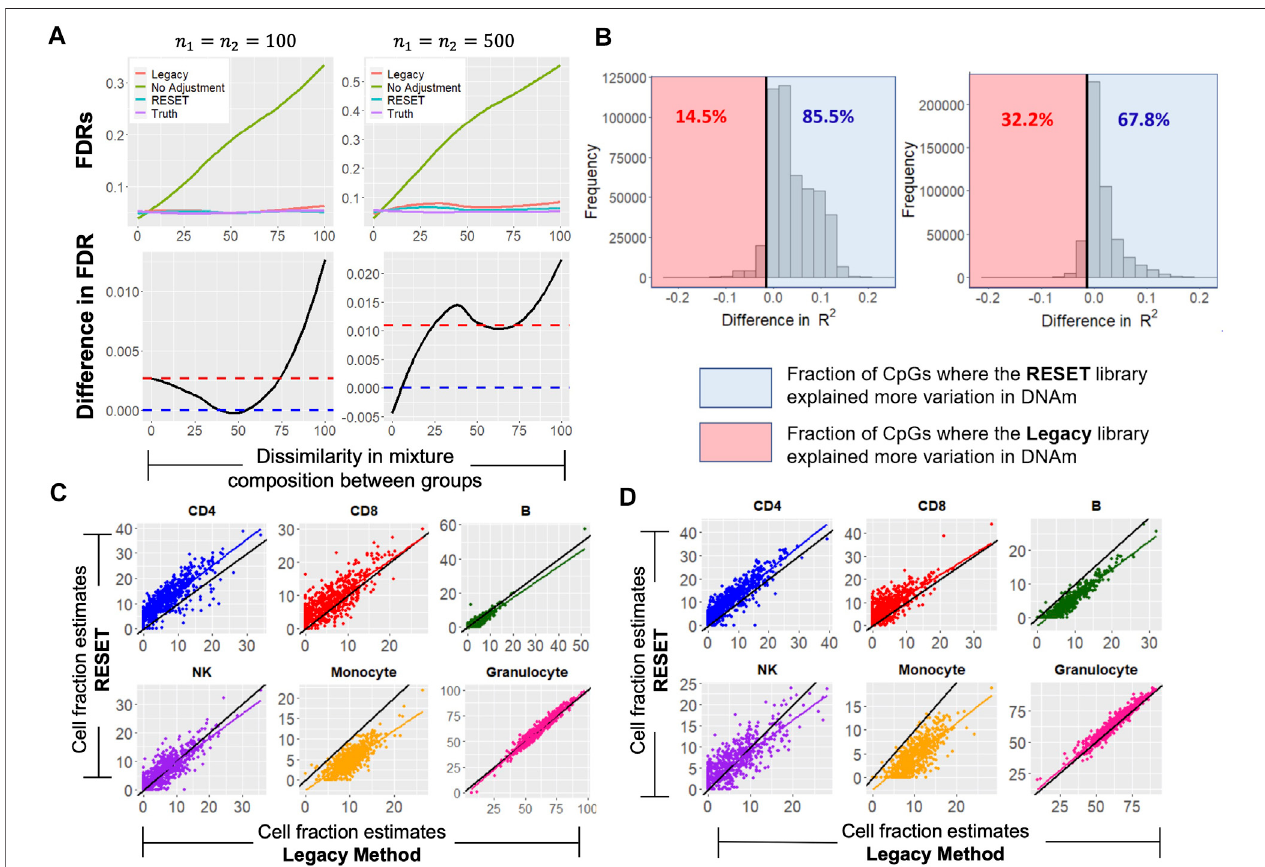
FIGURE 5 | FDR Simulation Results and Data Application Results for the DML Reference Library of Size 120. (A) Results from the FDR simulation to explore implications of prediction error in cell proportion estimates for EWAS as described in section 2.5.4 . The top panel shows the estimates of the FDR for the two-group comparison of methylation as a function of the dissimilarity in the distribution of cell-type composition between the two groups. The FDRs were estimated under four methods/approaches for cell composition adjustment. The bottom panel shows the difference in FDR estimates when cell type estimation was undertaken using the Legacy library versusthe RESET library. Points that lie above the blue dotted linesignifythat the Legacy library resulted in more false-positiveresults as compared to the RESET. The red dotted line shows the mean difference in FDR between the Legacy library and the RESET library. A loess smoother was used to generate these curves. (B) Distributionofthedifferencein R 2 obtainedfromtheRESETandLegacylibrariesofsize120CpGsappliedtotheLiu(leftpanel)andHannum(rightpanel)data setsdescribedin section2.5.5 . (C) Scatterplotsofthepredictedcell-typeproportionsusingtheLegacylibraryof120CpGs( x -axis)andtheRESETlibraryof120CpGs ( y -axis) as applied to the Liu data set. (D) Scatter plots of the predicted cell-type proportions using the Legacy library of 120 CpGs ( x -axis) and the RESET library of 120 CpGs ( y -axis) as applied to the Hannum data